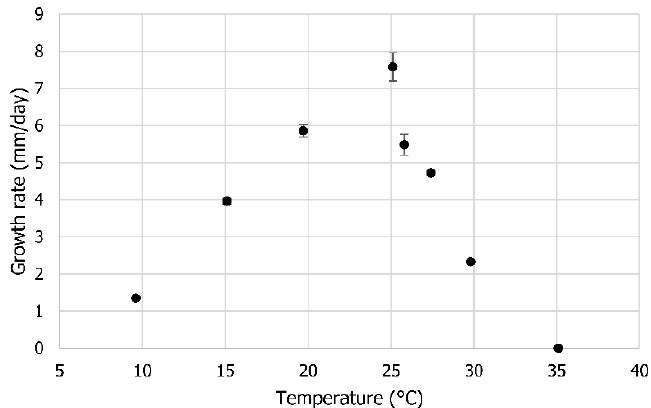
Figure 4. Growth rate of Cryptostroma corticale on PDA. Bars = standard error